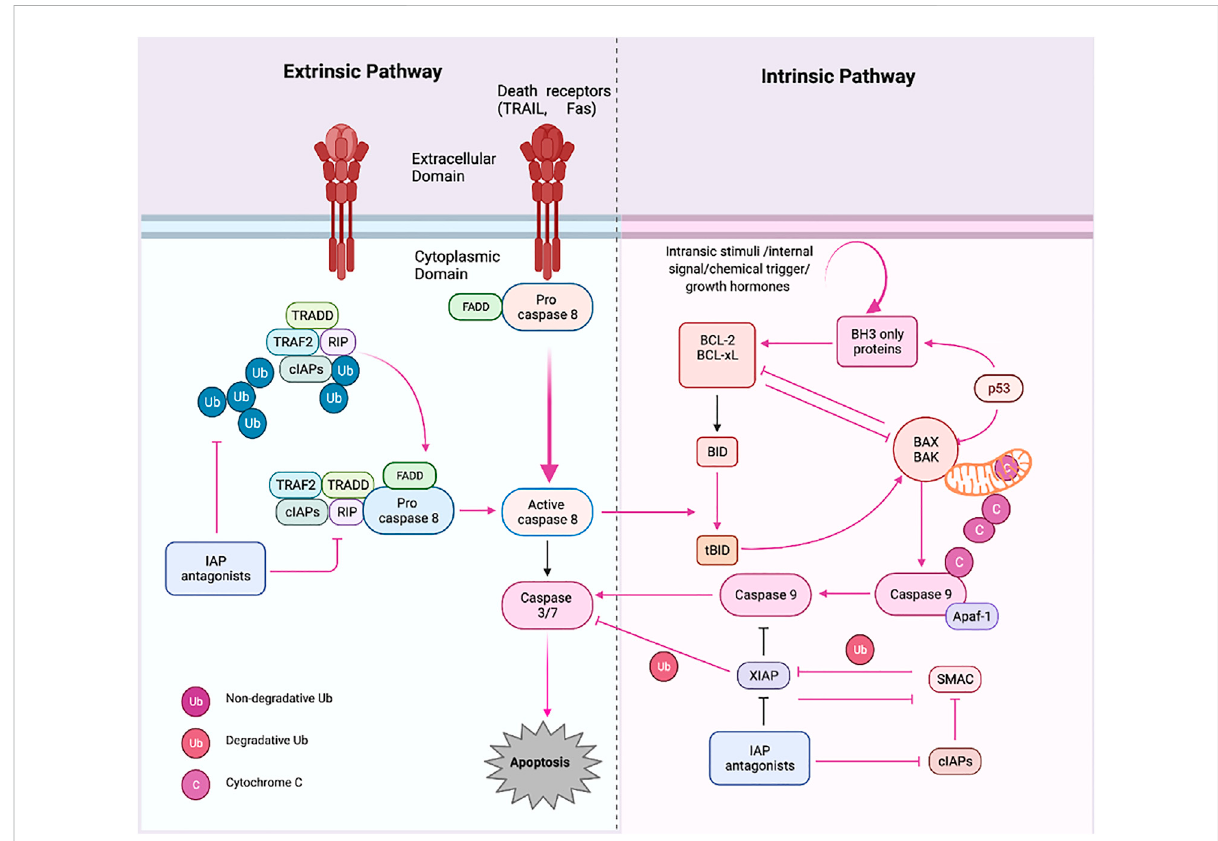
FIGURE 3 Apoptosis pathways. Apoptosis has two primary routes known as the i) extrinsic and ii) intrinsic pathway. First, external stimuli or ligand moleculesactivatethetransduction,includingdeathreceptors(SDRs),leadingtocaspase3/7activationvia/oractivatedcaspase8.Intrinsicpathway; via insertion of proapoptotic molecules BAX (protein) into the mitochondrial membrane results in the generation of cytochrome c, forming an apoptosome, which further triggers the apoptotic cascades beginning with proapoptotic activation caspase 9 and or then caspase 3. Created with